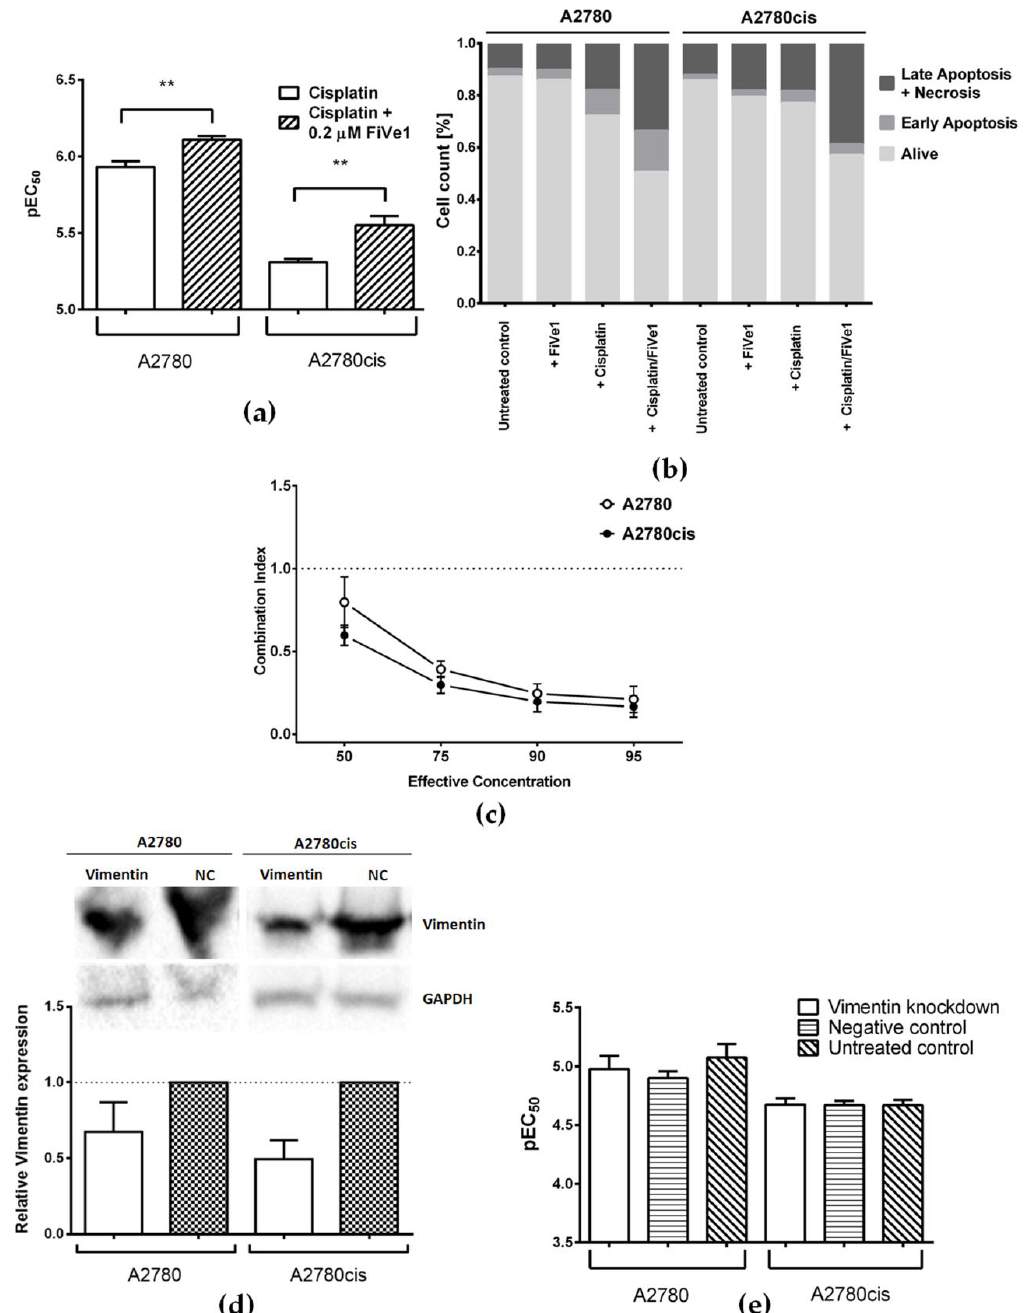
Figure 3. ( a ) Cisplatin cytotoxicity in A2780 and A2780cis cells alone or upon co-incubation with 0.2 µ M FiVe1 (mean ± SEM, n = 4–6); ( b ) percentage of early apoptotic, late apoptotic, and necrotic, as well as alive, cells in A2780 and A2780cis cells after the co-incubation of cisplatin with FiVe1, in comparison to the treatment with each of the compounds alone and untreated cells; ( c ) Combination Index (CI) of cisplatin and FiVe1; as described by Chou et al. [27], CI was determined at effective concentrations from EC 50 to EC 95 (mean ± SEM, n = 8); ( d ) representative Western Blots and densitometric quantification of protein expression after treatment with vimentin-specific and negative control (NC) siRNA in A2780 and A2780cis cells, where GAPDH served as a loading control (mean ± SEM, n = 3); ( e ) cisplatin cytotoxicity in A2780 and A2780cis cells after vimentin knockdown, prior treatment with negative control siRNA, or no pre-treatment (mean ± SEM, n = 4). ** p < 0.01.